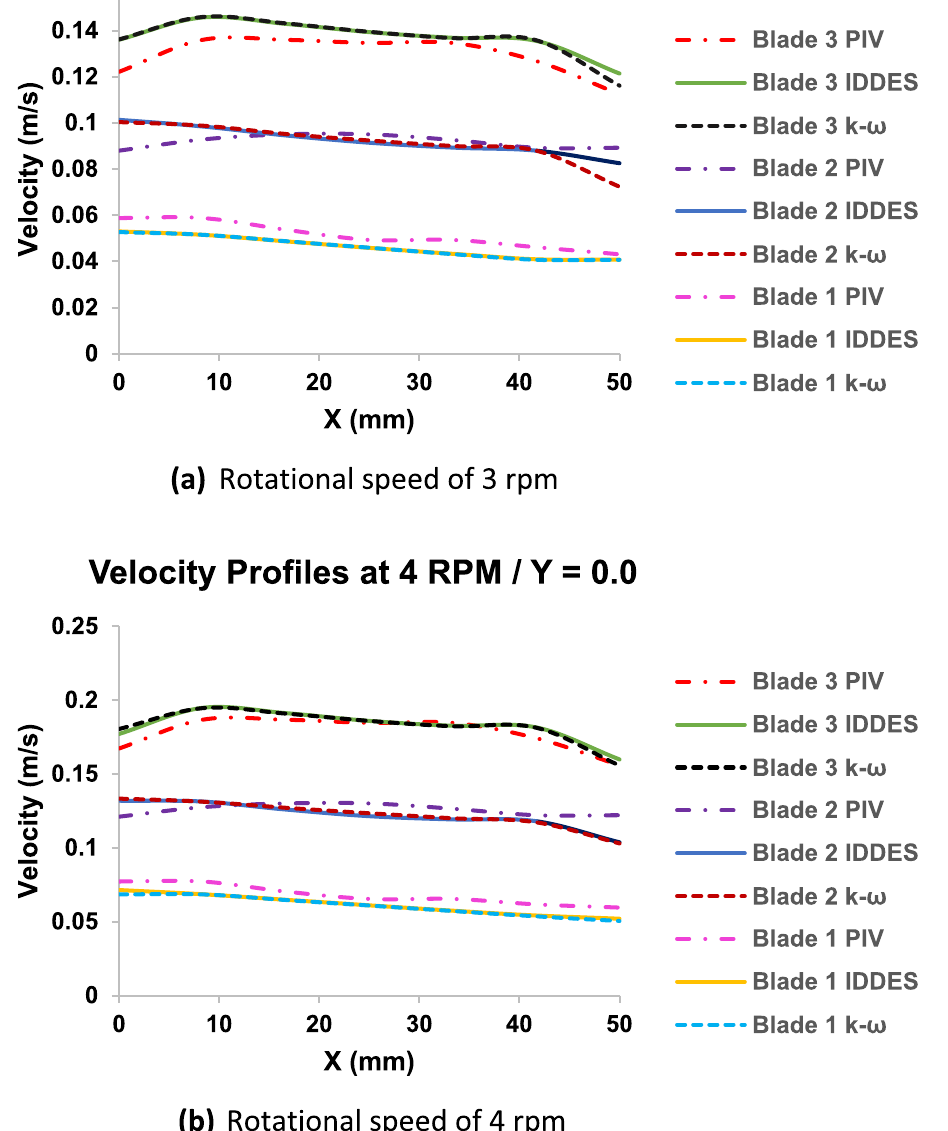
Figure 8. PIV, IDDES and SST k–ω velocity profiles at the surface of the blade. The x-axis represents the width of each blade in mm, with the origin (0 mm) represents the left periphery of blades, while the end (50 mm) represents the right periphery of